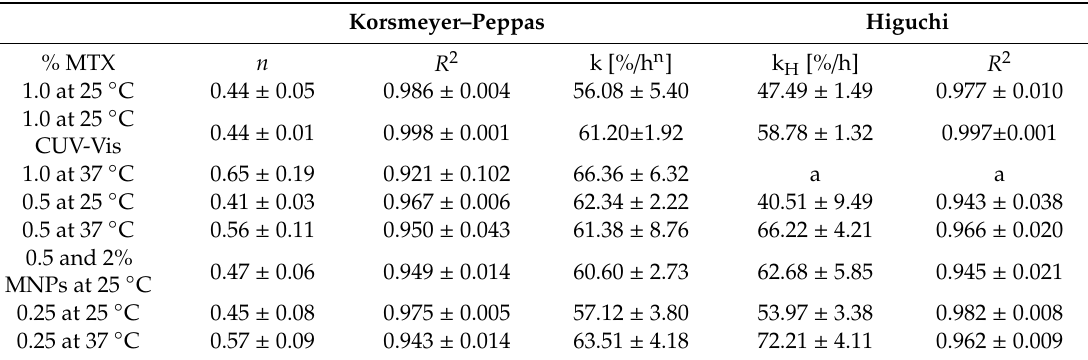
Table 2. Release characteristics of methotrexate from LCPs.